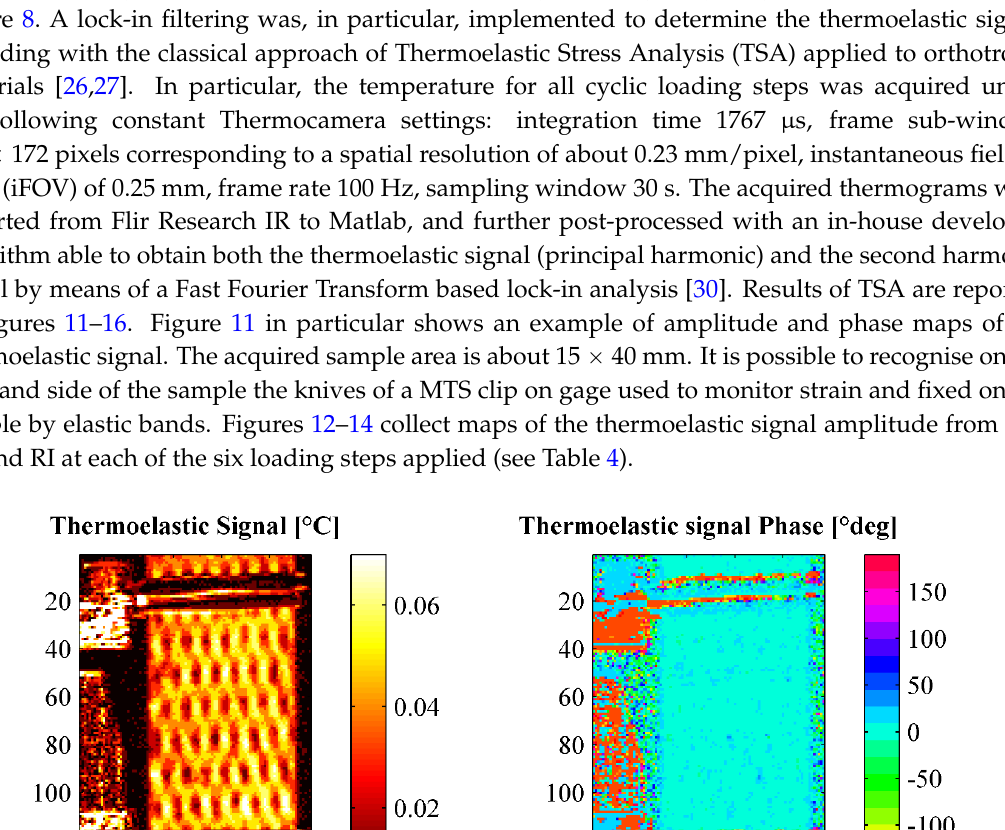
( f ) Figure 12. Thermoelastic signal amplitude Δ T in (°C) from an HL sample at the various loading steps. ( a ) load step 1; ( b ) load step 2; ( c ) load step 3; ( d ) load step 4; ( e ) load step 5; ( f ) load step 6.